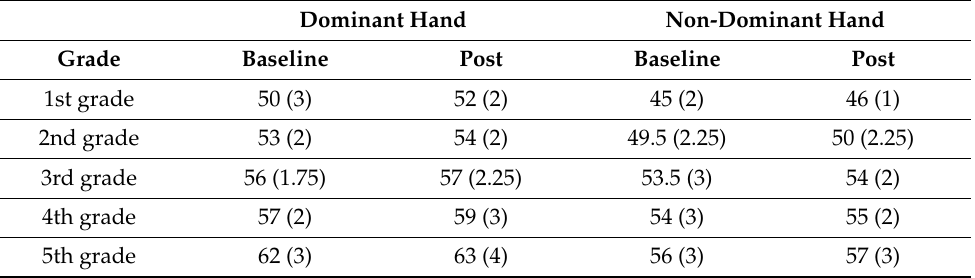
Table 12. BBT scores 1 comparison between the baseline and post-gross motor skills training assess- ments.